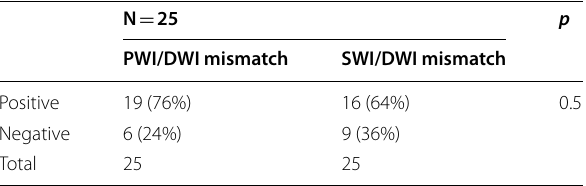
Table 5 Comparison between PWI/DWI mismatch and SWI and